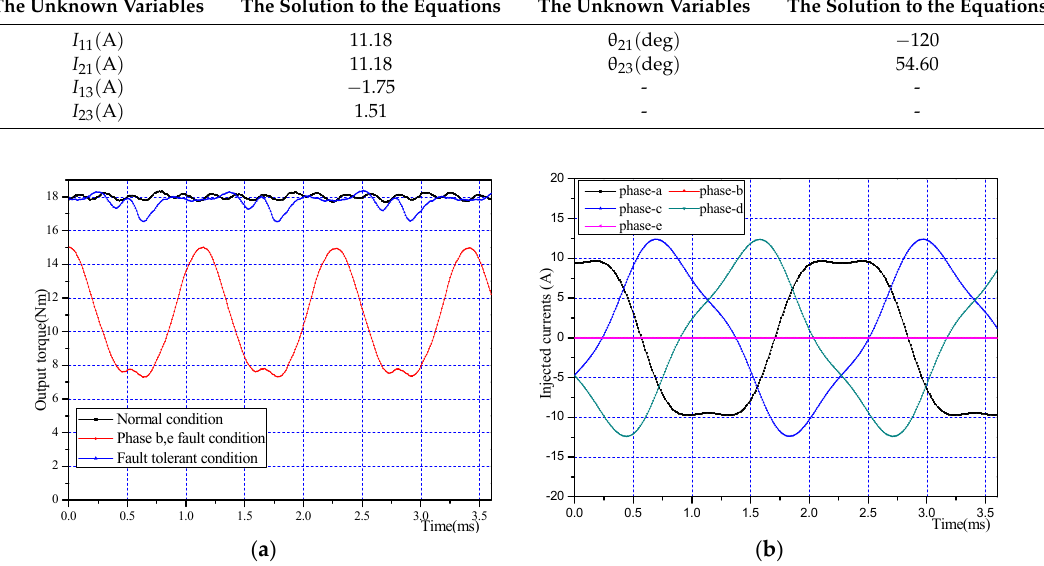
Figure 7. The motor operates under non ‐ adjacent double ‐ phase open circuit conditions: ( a ) electromagnetic torque obtained by FEA, and ( b ) the injected fault ‐ tolerant currents.